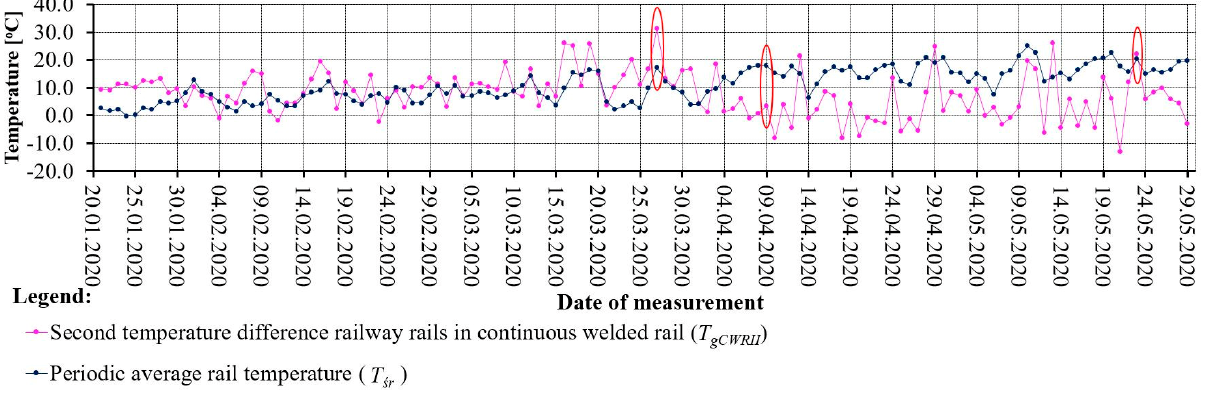
Figure 7. Graphical interpretation of the second rail temperature difference indicator (T gCWRII ) and the periodic average temperature (T ś r ).